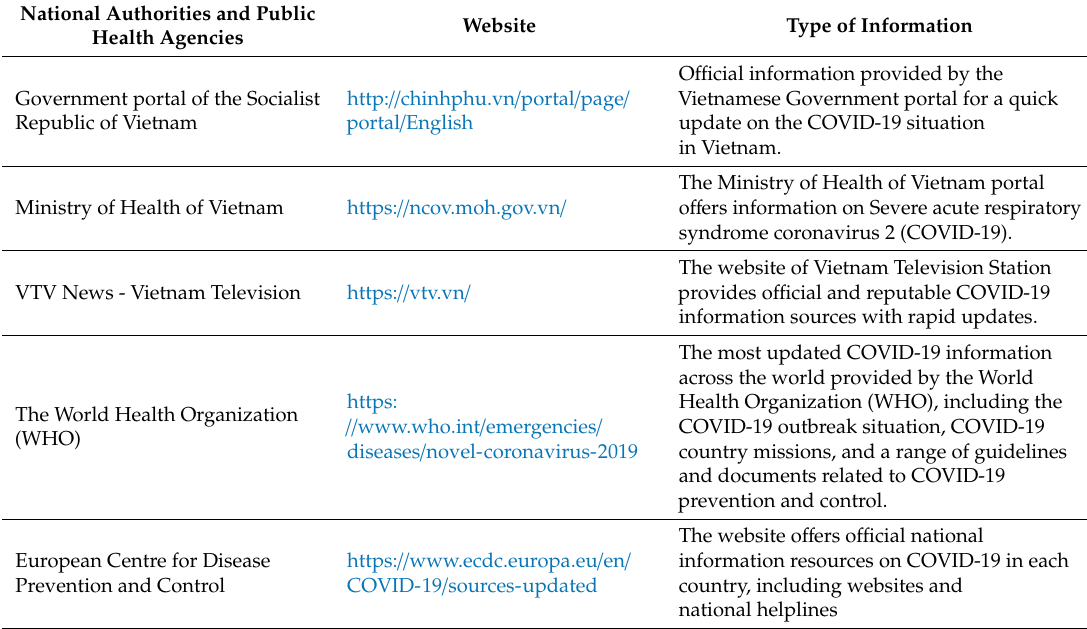
Table 6. O ffi cial sources of COVID-19-related information internationally and in